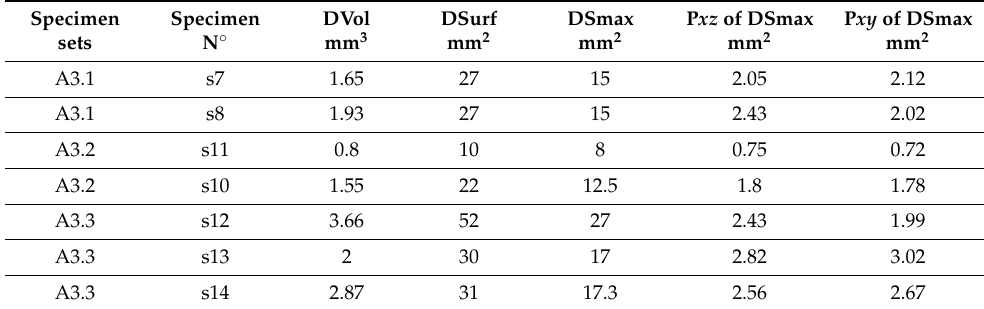
Table 4. Tomography Defect Metrics A3 alloys.